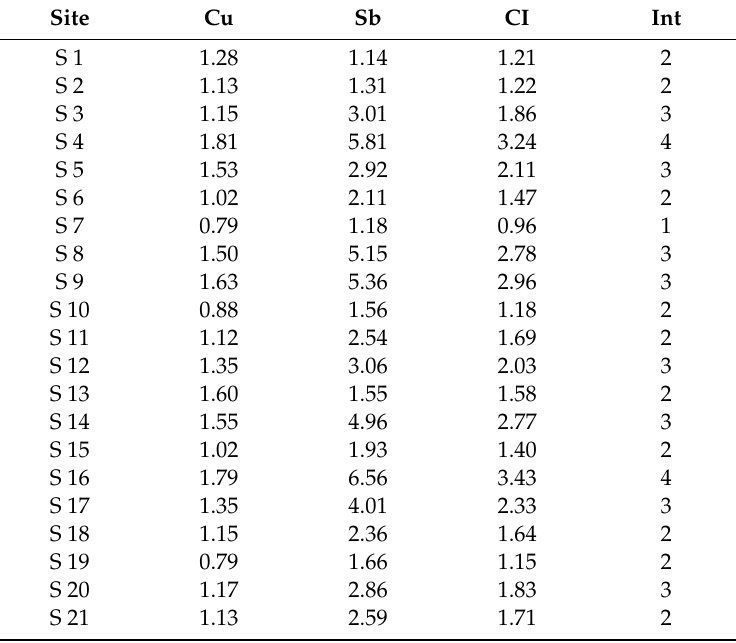
Table 3 summarizes the ranges (min–max) of the 95% confidence interval for the estimated